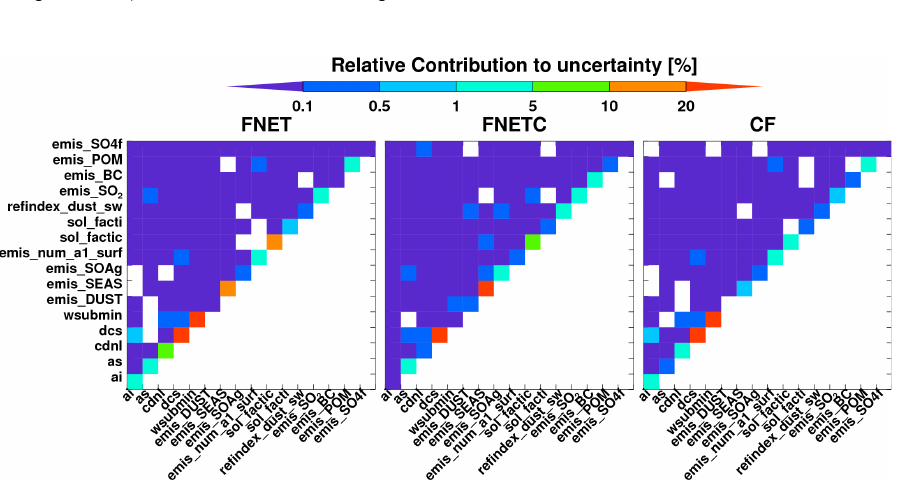
Figure 5 Relative contributions (percentage) of perturbations of individual parameter and their interactions to the variations of FNET, FNETC, and CF estimated by the GLM.